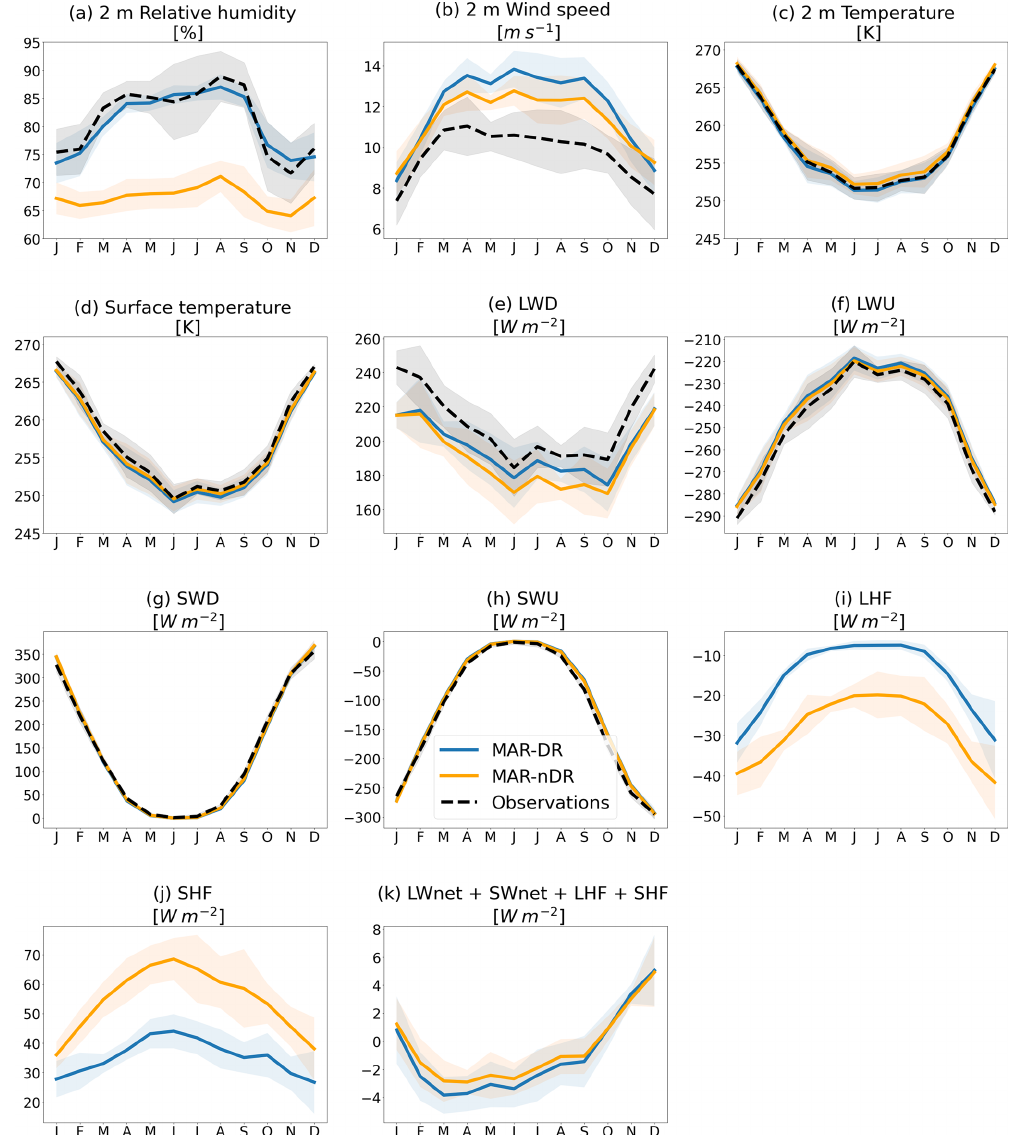
Figure 4. 2m and near-surface variable monthly means as simulated by MAR-DR and MAR-nDR. First, data are aggregated by both months and years. Then means and standard deviations are evaluated within each group aggregated by month. Statistics are performed on the 2014– 2018 period for radiative fluxes and surface temperature and on the 2010–2018 period for near-surface variables and turbulent